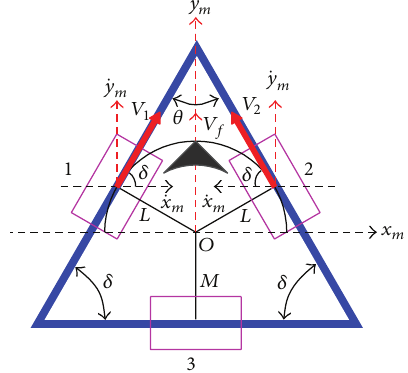
Figure 6: Forward movement schematic of chassis.